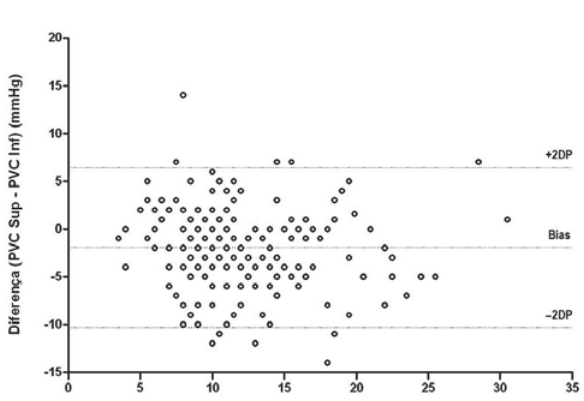
Fig. 4 - Média da PVC superior vs. inferior em inclinação de trinta graus. Gráfico de Bland-Altman mostrando a média da diferença entre a pressão venosa central superior e femoral (Bias) em inclinação da cabeceira do leito em trinta graus; 0,4 mmHg com limite de concordância 95% (representado por ± 2DP) de –10,0 a 10,8 mmHg. DP – desvio